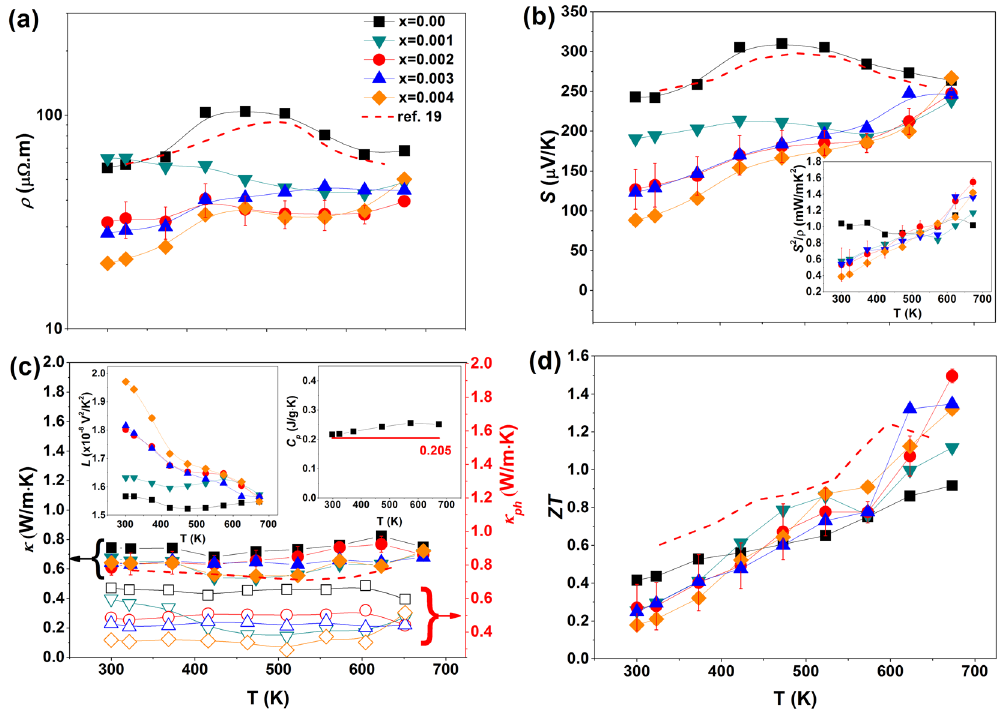
Figure 4. Effect of temperature on the thermoelectric (TE) properties of Ce-doped AgSb 1 − x Ce x Te 2 : ( a ) electrical resistivity, ( b ) Seebeck coefficient; the inset shows the power factors, ( c ) total thermal conductivity (solid shapes) and lattice thermal conductivity (open shapes); the left and right insets show the Lorenz number and the heat capacity, respectively. (The red line of 0.205 J/g∙K in the right inset in ( c ) represents the literature value from ref. 14.), and ( d ) the dimensionless figure of merit ( ZT ). The red dashed lines in all four panels are the corresponding data from ref. 19., while that in ( c ) is the total thermal conductivity from ref. 19.